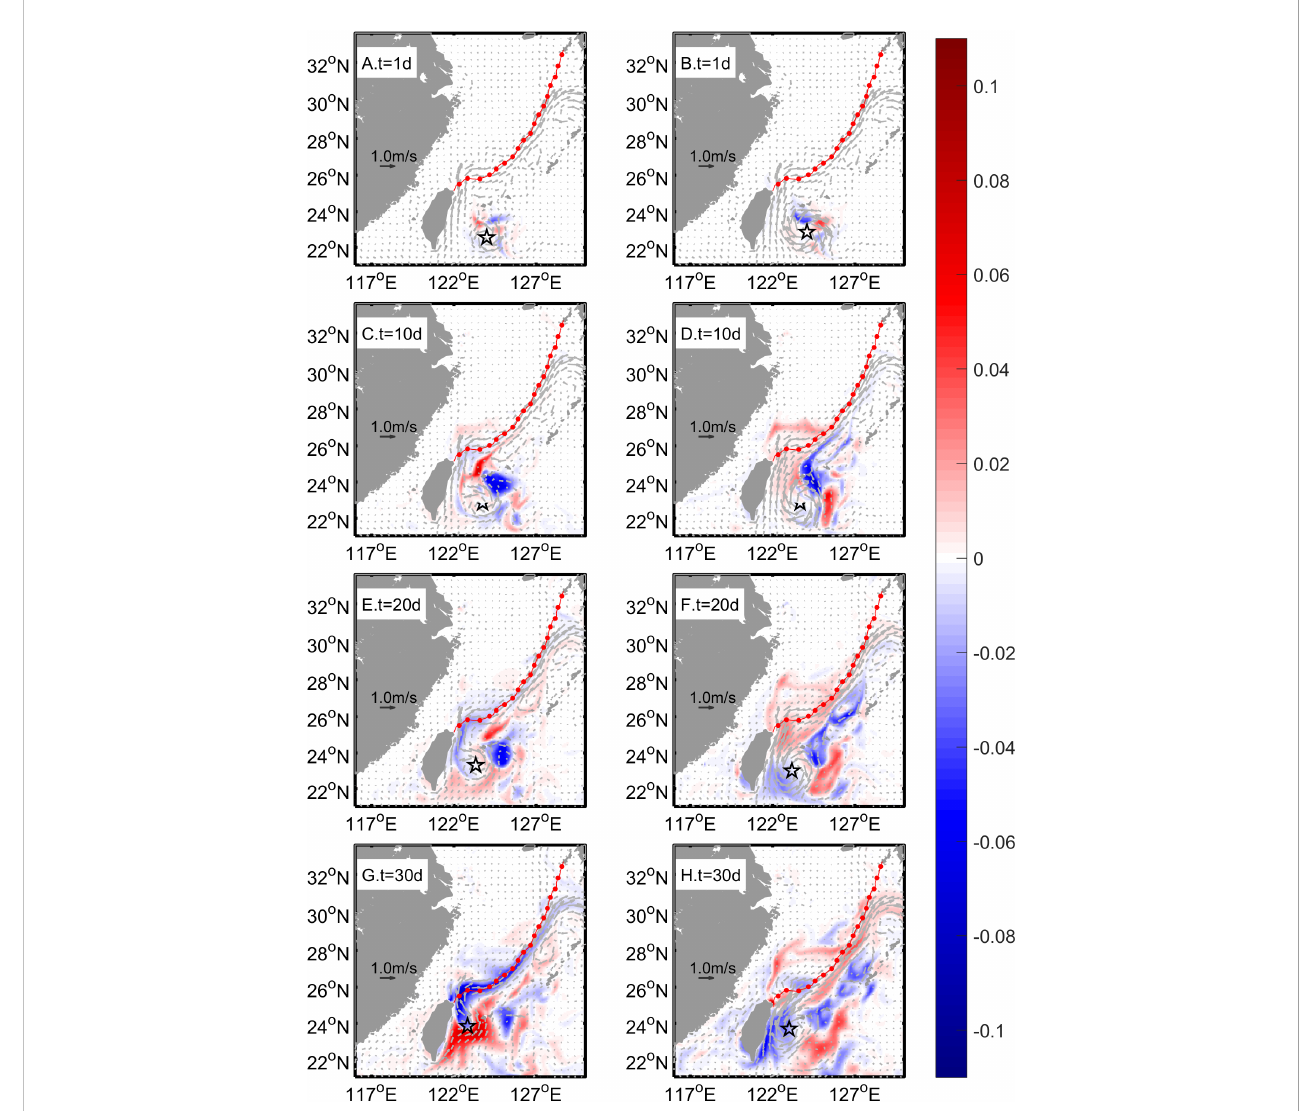
FIGURE 13 The variations in surface phosphate concentration (kg/m 3 ) under the in fl uence of (left panels) cyclonic and (right panels) anticyclonic eddies at t= (A, B) 1 day, (C, D) 10 days, (E, F) 20 days, and (G, H) 30days. The surface current fi elds at different times are included. The red dashed lines indicate the 200 m isobaths. The black stars indicate the location of the eddy